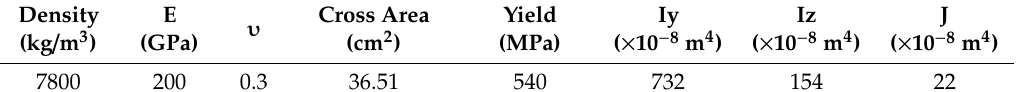
Figure 4. Modelling of steel arch for roof support.